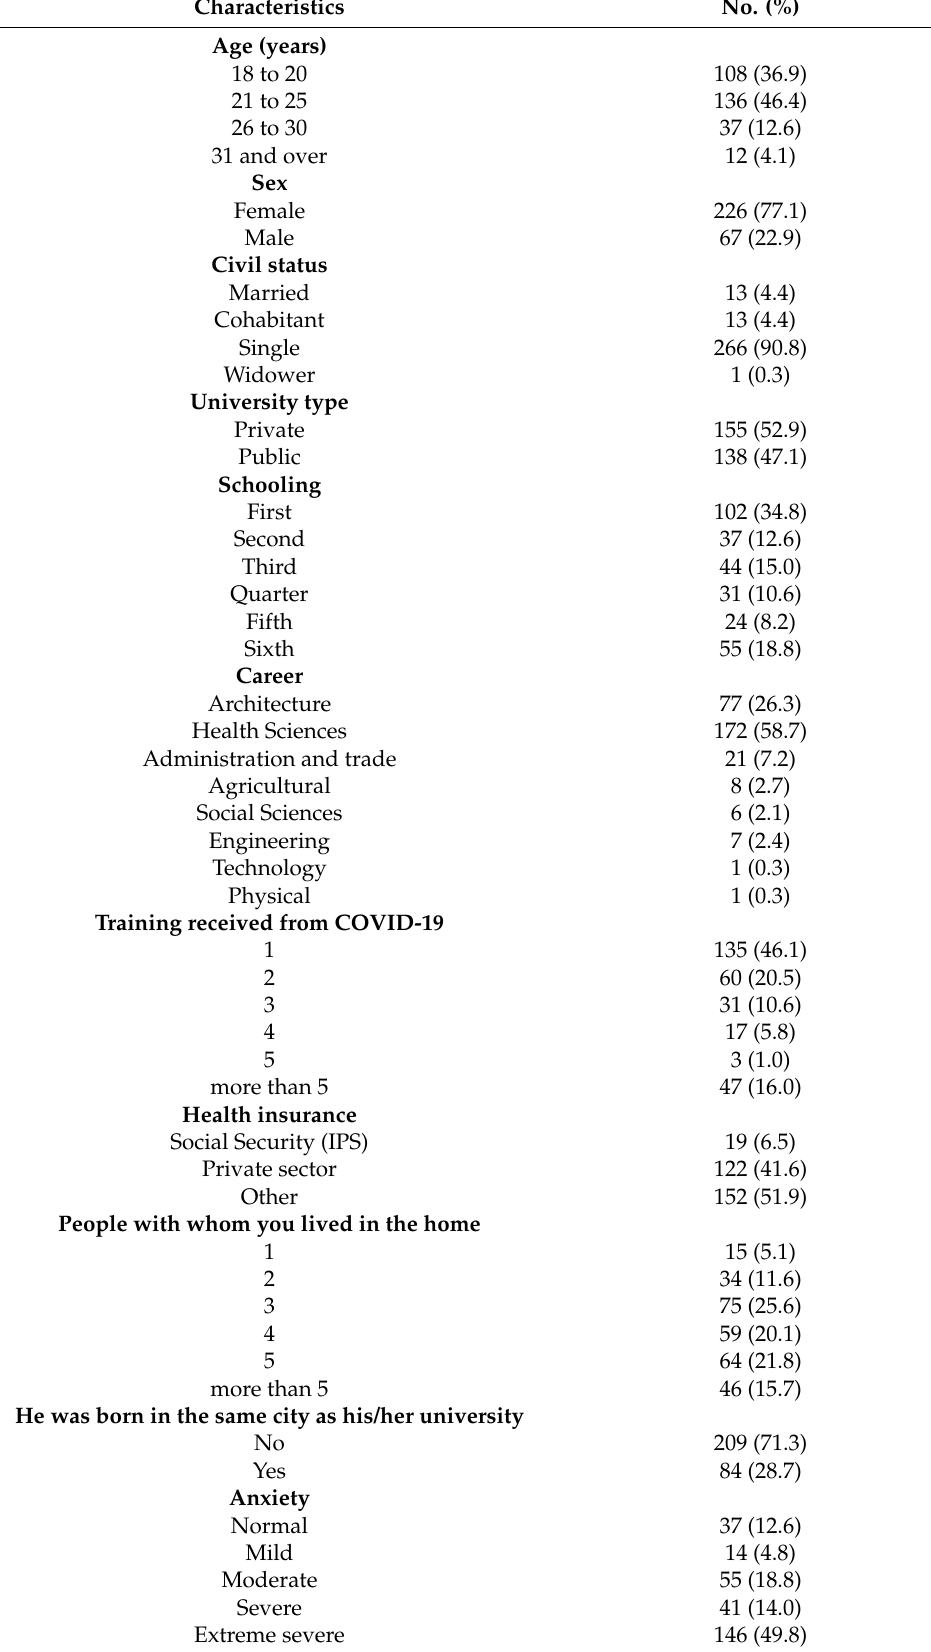
Table 1. Socio-educational characteristics of